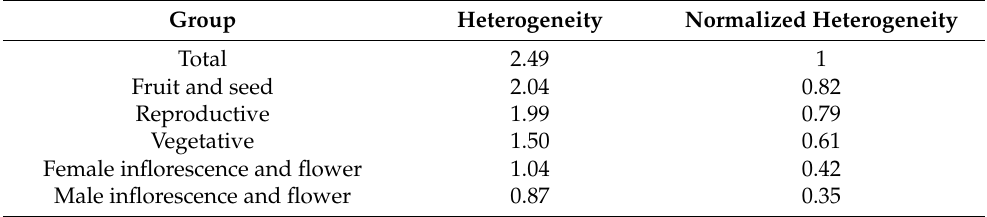
Table 3. Contribution to the total heterogeneity of Phoenix by the different groups of descriptors 1 . Group Heterogeneity Normalized Heterogeneity Total 2.49 1 Fruit and seed 2.04 0.82 Reproductive 1.99 0.79 Vegetative 1.50 0.61 Female inflorescence and flower 1.04 0.42 Male inflorescence and flower 0.87